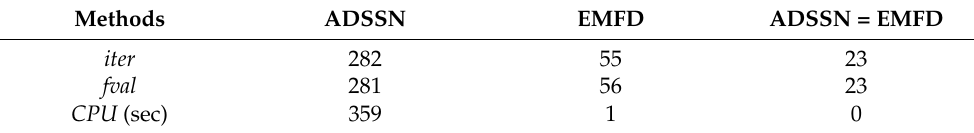
Table 2. IADSSN-EMFD